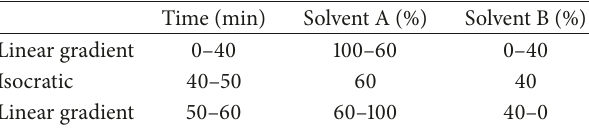
Table 1: System gradient used for HPLC